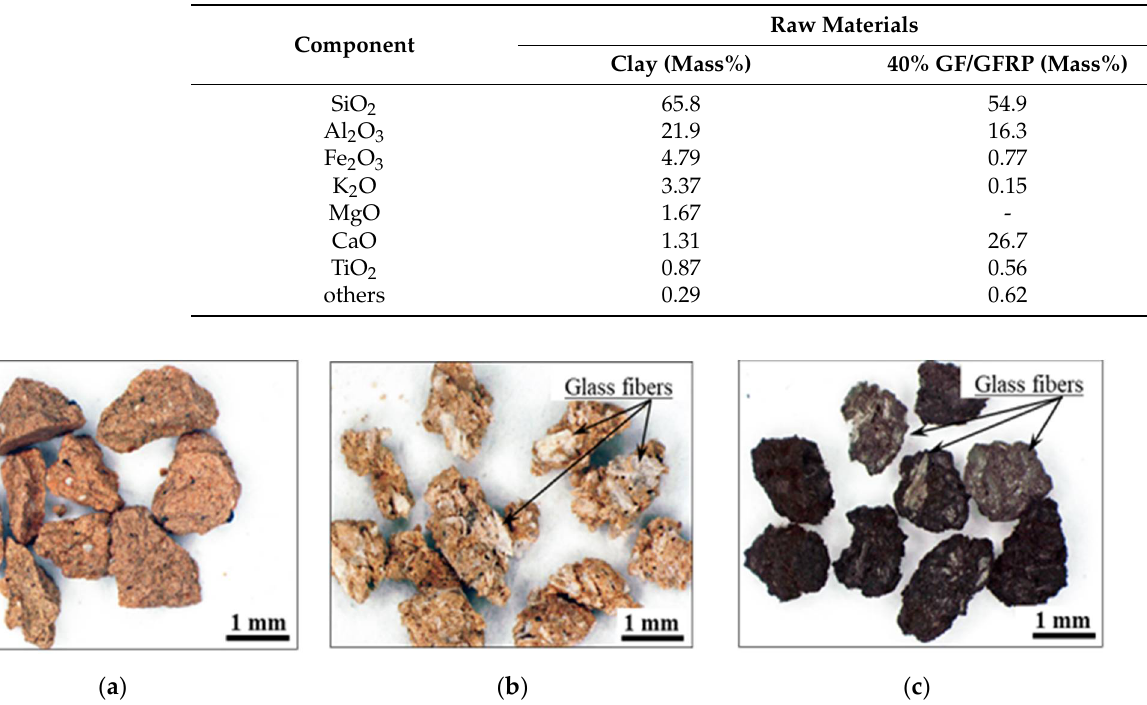
Figure 2. Microscope images of the samples. ( a ) Clay ( b ) 60% GFRP/clay (Oxidatively fired) ( c ) 60% GFRP/clay (Reductively fired).